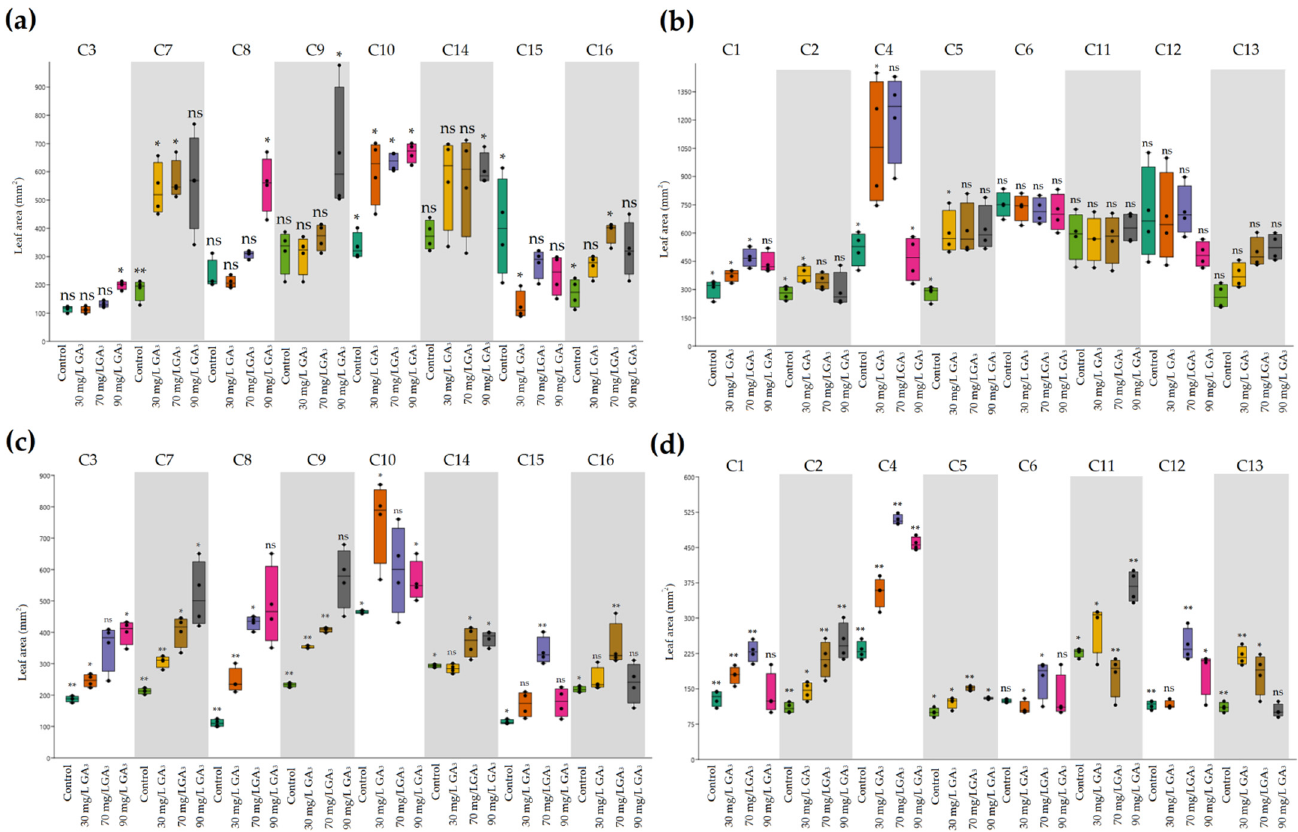
Figure 1. The effects of ambient temperature and high temperature stress and exogenously applied GA 3 on leaf area of heat-tolerant ( a , c ) and heat-sensitive ( b , d ) genotypes. * Significant at 5% probability level; ** significant at 1% probability level; ns, no significant difference.